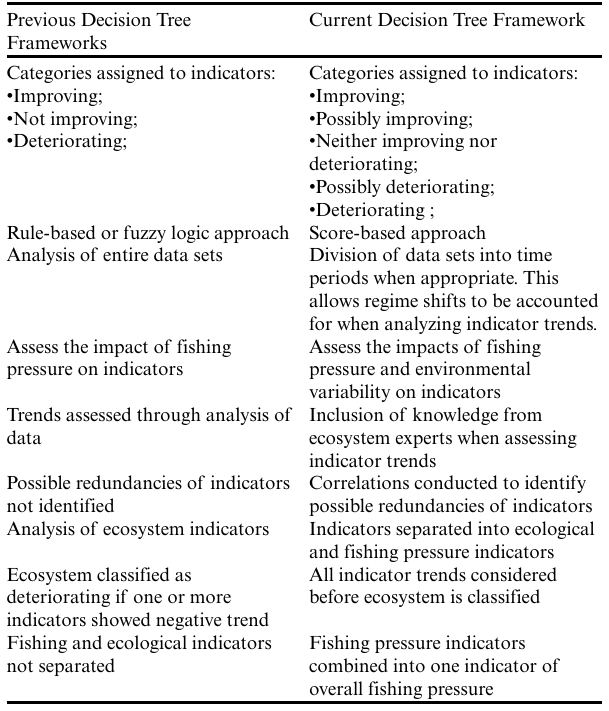
Table 2 . Comparison of methods employed in previous decision trees with the decision tree developed in this